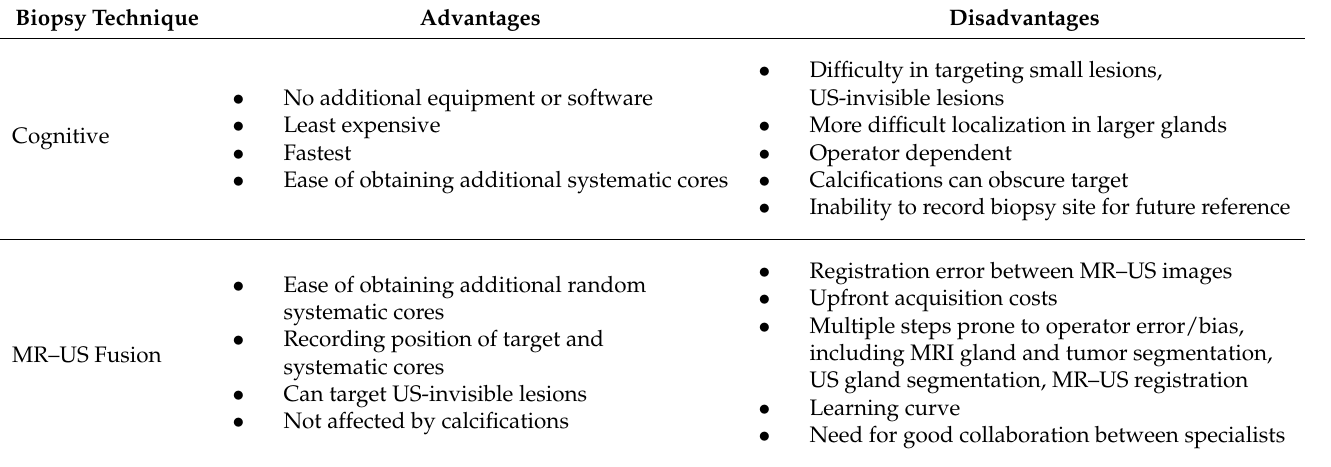
Table 1. Summary of advantages and disadvantages of different biopsy techniques. Biopsy